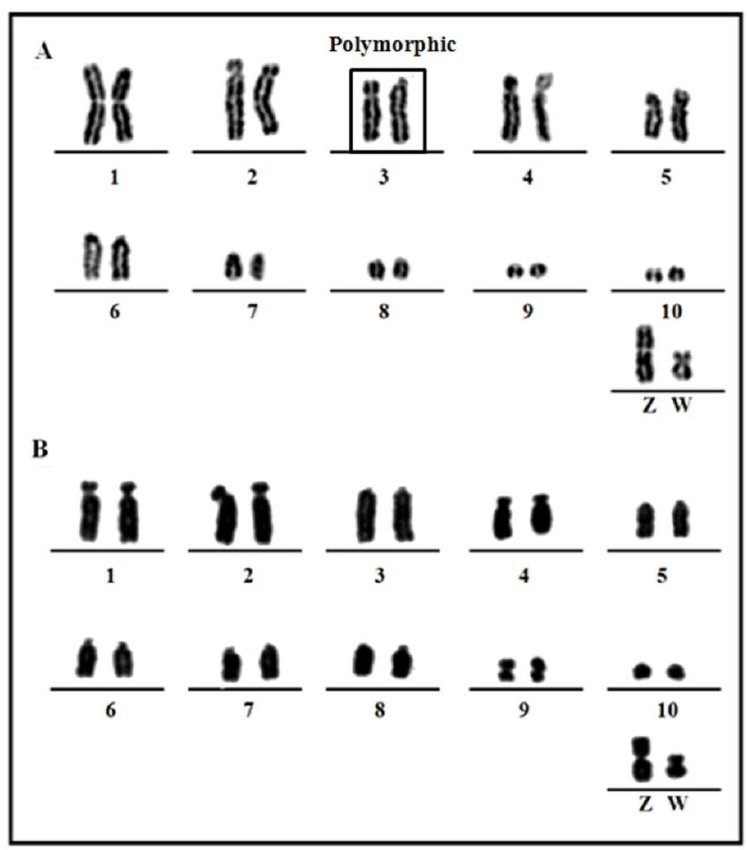
Figure 1. Partial karyotypes conventionally stained of the two species: ( A ) Pyrrhura frontalis , 2n = 70, ( B ) Amazona aestiva 2n = 70. Heteromorphic chromosome pair is boxed.